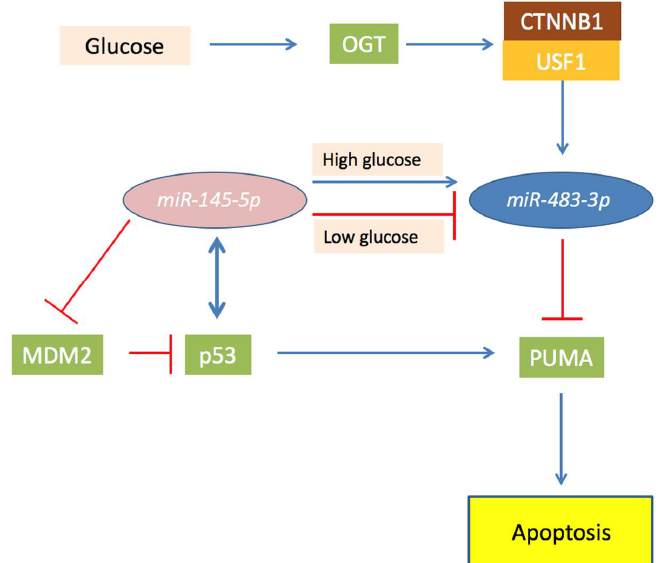
Figure 3. Schematic representation of the role of O -linked β- N -acetylglucosamine transferase (OGT) and miR-483-3p in the miR-145-5p/TP53 axis in hepatocellular carcinoma (HCC). In the Figure are showed proteins (squares) and miRNAs (ovals) and their functional connection involved in the miR-145-5p /TP53 axis in HCC. Briefly, miR-145-5p targets MDM2 and reduces expression of miR-483-3p , permitting the activation of TP53 that induce PUMA and apoptosis. In case of OGT over-activity, miR- 145-5p is unable to regulate miR-483-3p which expression is increased by CTNNB1 activity. This leads the miR-483-3p to target PUMA and blocking the pro-apoptotic effect of TP53.